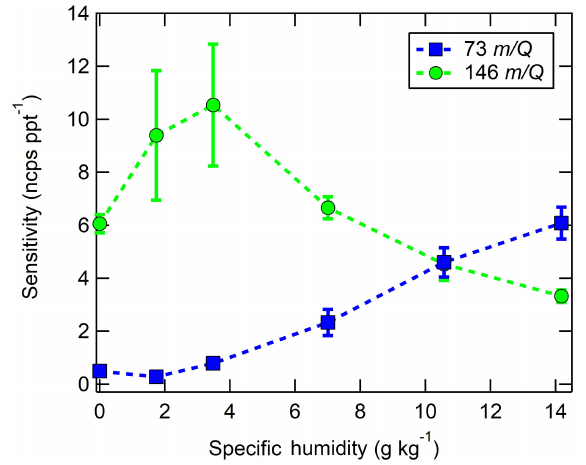
Figure 6. Humidity-dependent CI-ToFMS sensitivities to isoprene · C (green circles, C 6 H + 5 H 8 , 146 m/Q ), and the protonated water 6 tetramer (blue squares, H 3 O + · (H 2 O ) 3 , 73 m/Q ), derived from calibration curves such as those shown in Fig. 6. The reported sensi- tivities are the average of triplicate calibration curves with all linear best fits having R 2 >0.98. Error bars represent the standard devia- tion of the triplicate calibrations. All calibrations were performed in zero air.